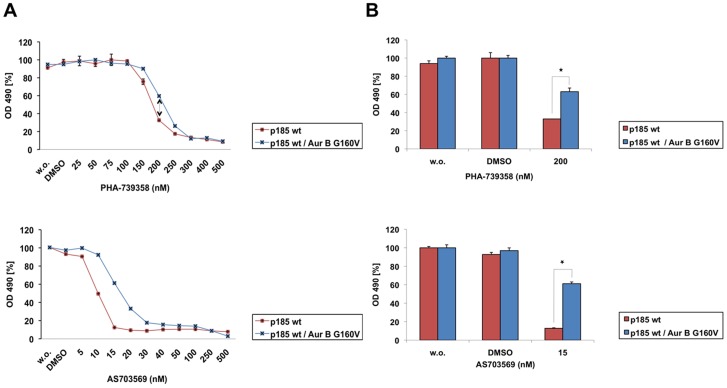
Drug-resistant Aurora B G160V mutant partly overcomes the anti-proliferative effect of PHA-739358 and R763/AS703569.(A) MTT assay showing the anti-proliferative effect after treatment with increasing concentrations of PHA-739358 (upper panel) or R763/AS703569 (lower panel) for 48 h. Percentage of cell growth was normalized to the growth of untreated control cells. Shown is one representative experiment of three experiments performed. (B) Bar graph quantifying cell proliferation after exposure to 200 nM PHA-739358 (upper panel) or 15 nM R763/AS703569 (lower panel) for 48 h. Untreated and DMSO-treated cells were used as control. Shown is one representative experiment of three experiments performed. Values show mean of triplicates ± SD. Difference between Ba/F3 p185 wt and AurB G160V expressing Ba/F3 p185 wt cells is statistically significant.